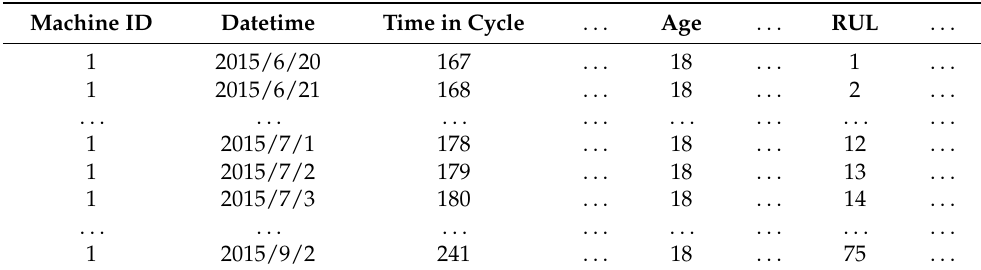
Table 1. Part of the project data used in our case